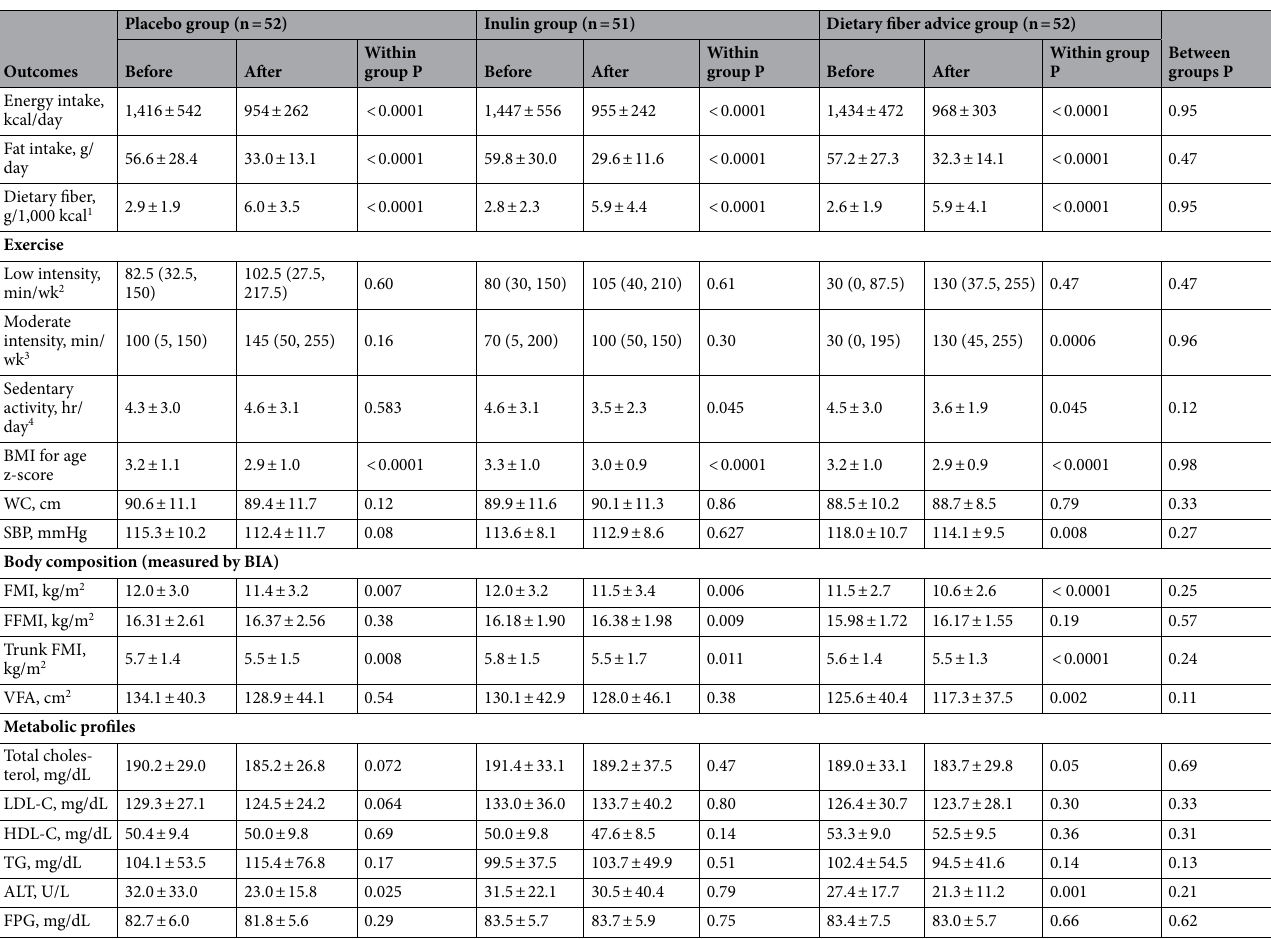
Table 2. Changes in anthropometry, body composition, and nutrient intake in obese children after receiving inulin, placebo, and dietary fiber advice for 6 months (observed mean of outcomes). Data was shown as means ± SD and median (Q1, Q3). Pair t-test was used to compare mean difference within group and one- way ANOVA was used to determine differences between groups. Wilcoxon sign test was used to compare non-parametric variables between pre and post intervention within group and Kruskal–Wallis test was used to compare non-parametric changes among three groups. 1 This amount was from the participants’ diet only and inulin supplementation was not included. 2 Low intensity (min/wk) was walking from home to school or walking from one place to another for at least 10 min. 3 Moderate intensity (min/wk) was brisk walking or riding a bicycle continuously for at least 10 min. 4 Sedentary activity was defined as a type of lifestyle involving little or no physicalactivity. ALT, alanine aminotransferase; BIA, bioelectrical impedance analysis; C, cholesterol; FPG, fasting plasma glucose; FFMI, fat-free mass index = fat-free mass (kg)/height (m 2 );